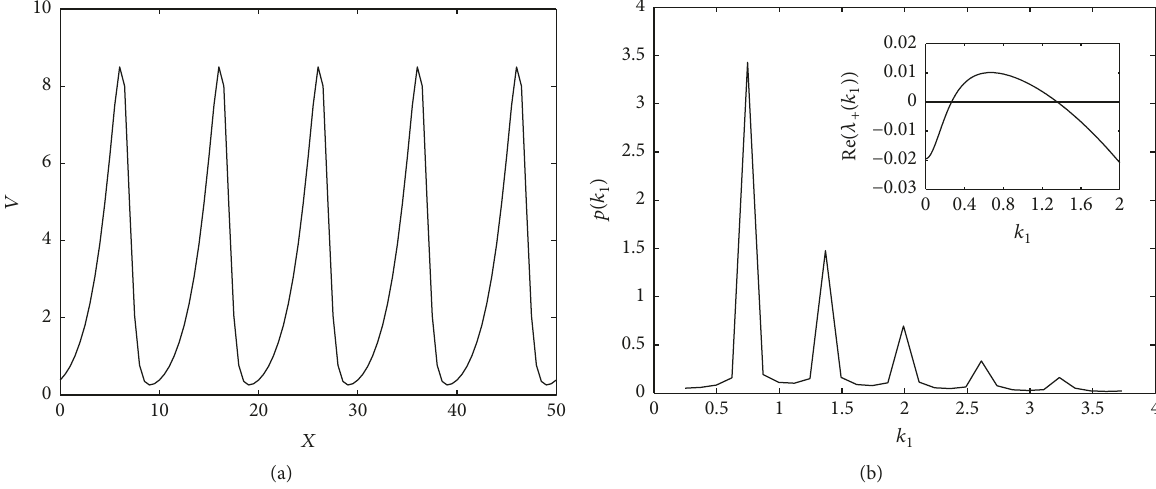
Figure 5: (a) Spatial wave of plant biomass, obtained by a cross-section of Figure 4(b); (b) power spectrum analysis for Figure 5(a), where the inner graph is the corresponding dispersion relation for Figure 4, plotted using (13a).